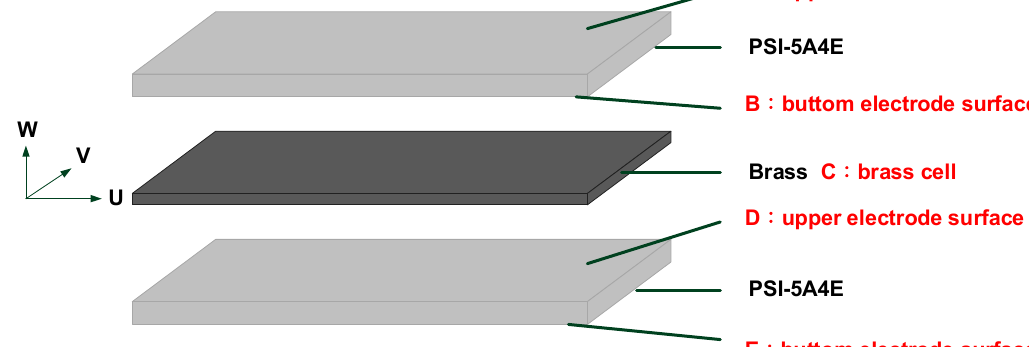
Figure 2. Thickness and construction of the PVEH plate. 3.2. Design and Modelling The fluid-structure interaction (FSI) simulation technique was used to investigate the vibrational performance of the coupled bluff splitter body and PVEH plate under different wind speeds. The FSI simulation requires the setup of both Computational Fluid Dynamics (CFD) and Computational Structural Dynamics (CSD) separately before data coupling setup. The T-shaped structural model is divided into two separate parts: thin elastic PVEH plate and bluff splitter body. As mentioned in Section 1, the PVEH plate with bimorph properties is constructed from a brass plate sandwiched between two PZT plates with a total dimension of 31.8 × 57 × 0.51 mm. The PVEH plate is placed onto the fixed boundary condition aluminum bluff splitter body with a cantilever boundary condition as